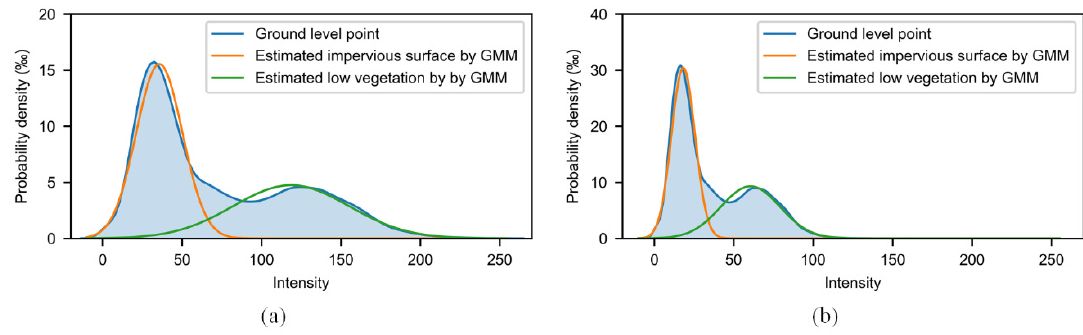
Figure 9. Intensity distribution of ground-level point in the supervised classification result, and GMM result for original intensity ( a ) and modified intensity ( b ). result for original intensity ( a ) and modified intensity ( b